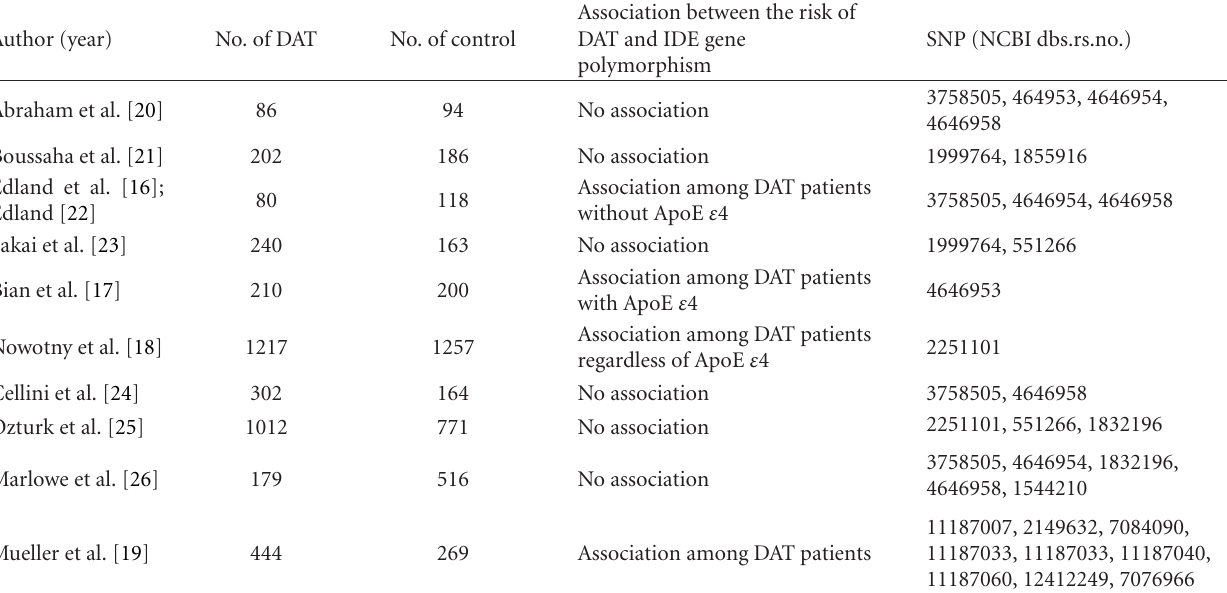
Table 5: Published studies of association between DAT onset and IDE gene